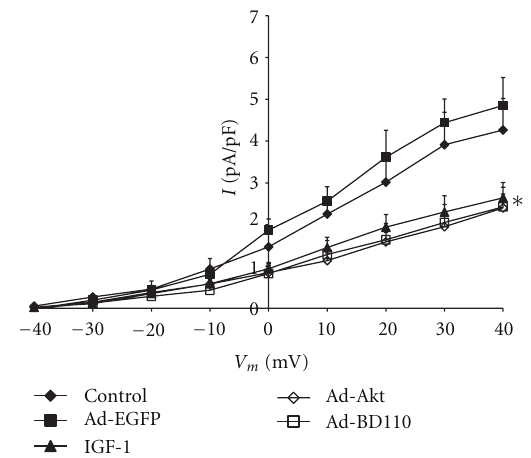
Figure 1: E ff ects of IGF-1, Ad.Akt and Ad.BD110 treatments on the I K -voltage relationship for normal neonatal rat cardiomyocytes. Data are presented as average current density (pA/pF) ± standard error. ∗ Significant di ff erence at P < 0 . 05 for control and Ad.EGFP versus IGF-1, Ad.Akt, and Ad.BD110